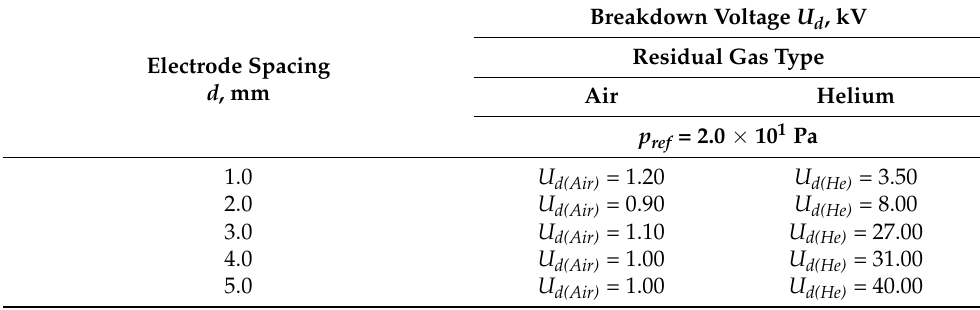
Table 6. Comparison of the breakdown voltages U d of vacuum interrupters filled with air and helium, for electrode spacing from 1.0 to 5.0 mm and reference pressure equal to p ref = 2.00 × 10 1